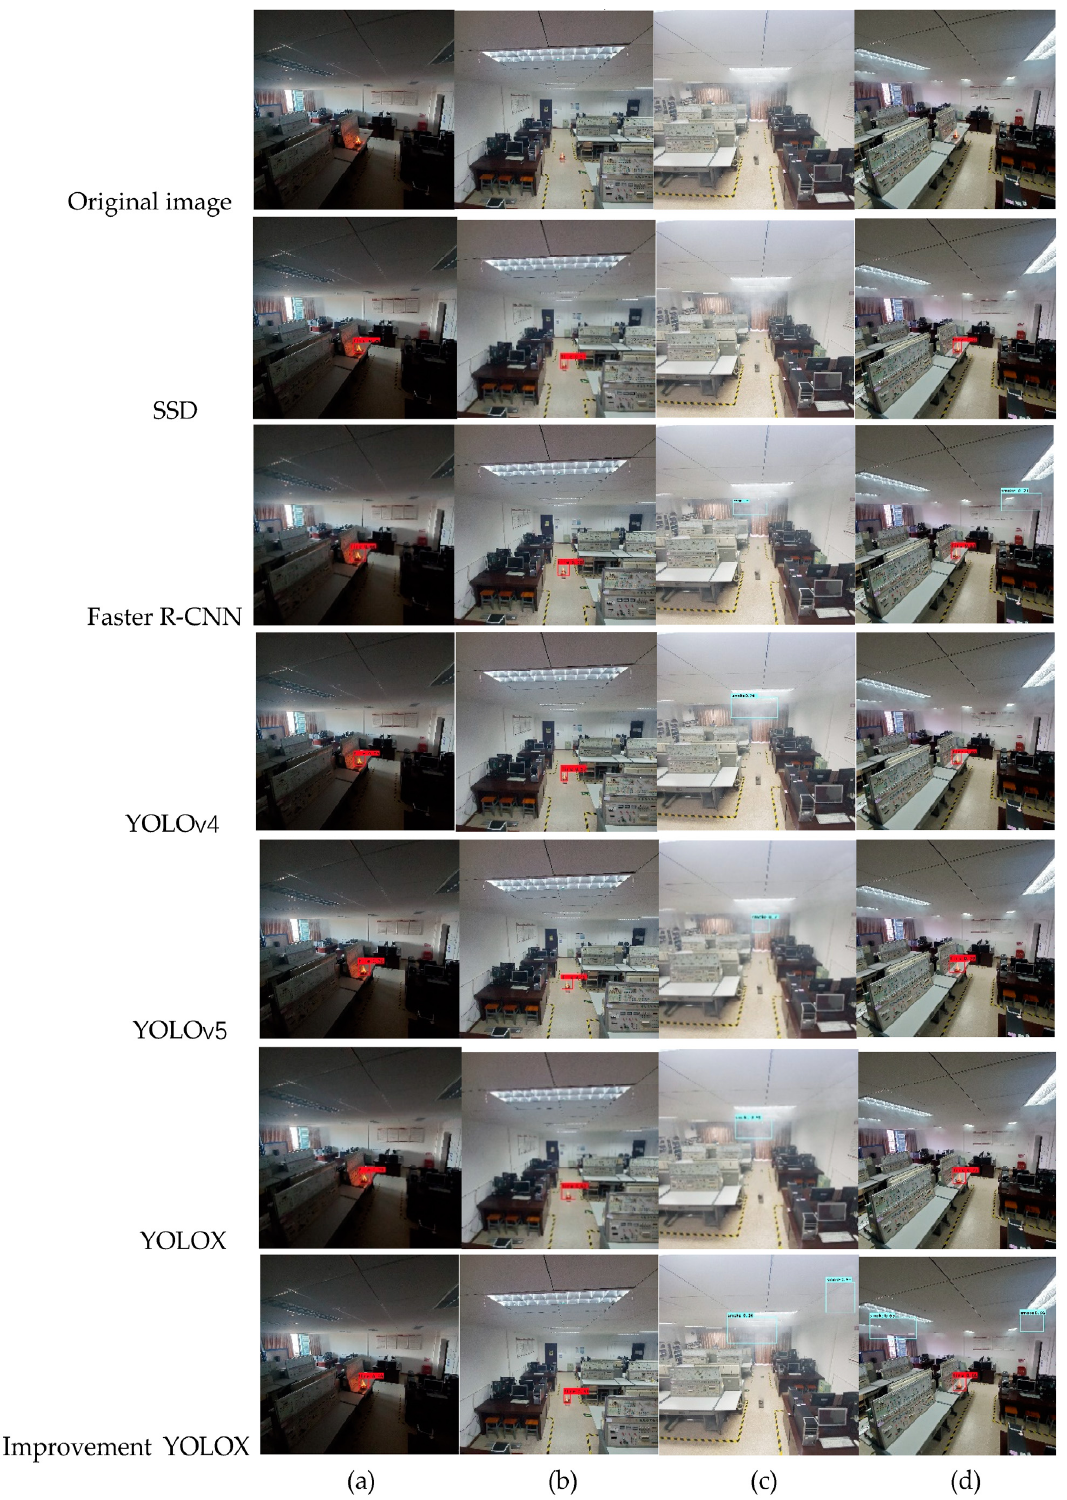
Figure 13. ( a ) Detection results of different algorithms in a darker environment with more visible flame and less visible smoke; ( b ) Detection results of different algorithms in a brighter environment with more visible smoke and less visible flame; ( c ) Detection results of different algorithms in a brighter environment with no flame and more visible smoke; ( d ) Detection results of different algorithms in a brighter environment with both flame and smoke